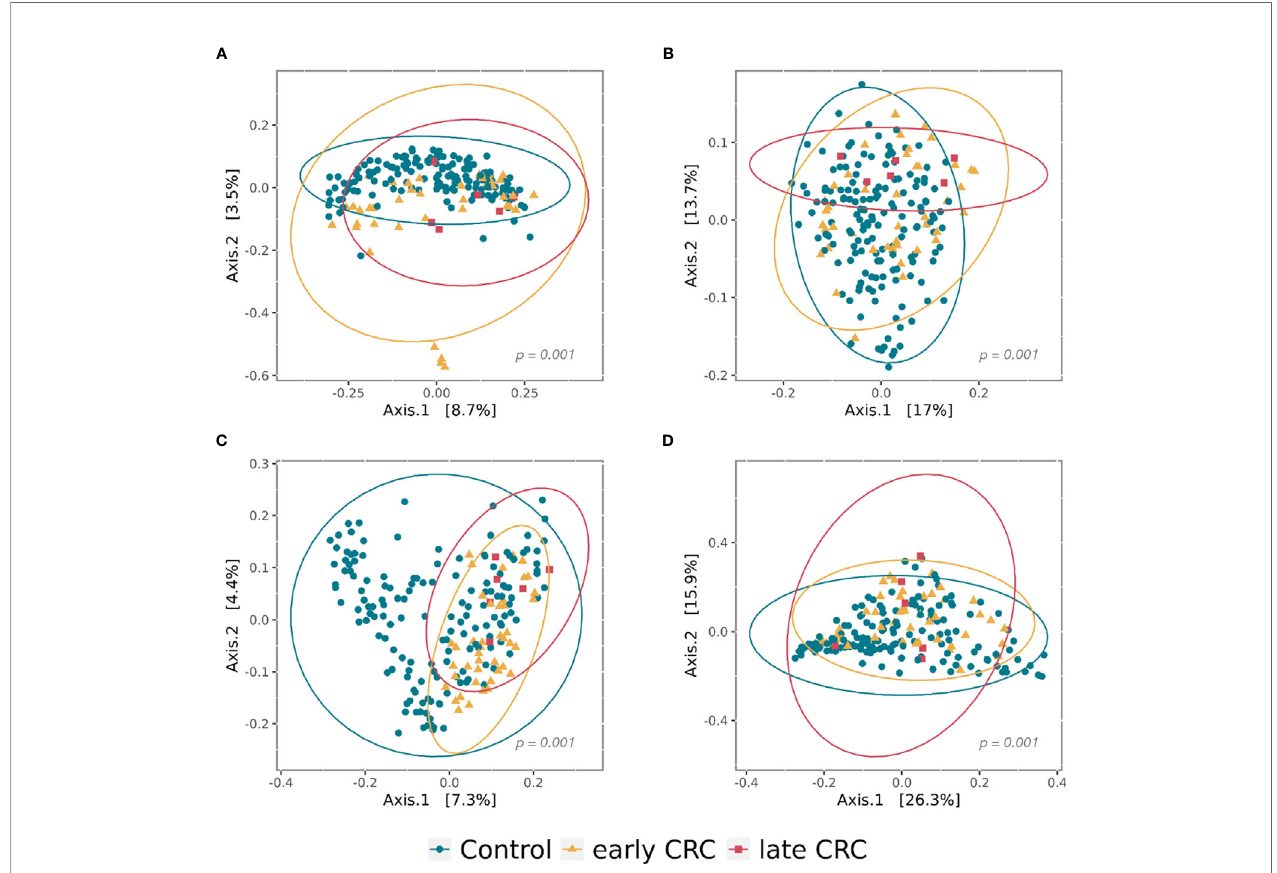
FIGURE 2 | Principal coordinate analysis (PCoA) plots of beta diversity analysis of control, early CRC, and late CRC patients in the gut microbiota (A – B) and the gut microbe-derived extracellular vesicles (C – D) . Between-sample dissimilarities were measured by unweighted UniFrac distances (A, C) and weighted UniFrac distances (B, D) . Permutational multivariate analysis of variance (PERMANOVA) was performed to analyze statistical signi fi cance (p = 0.001).